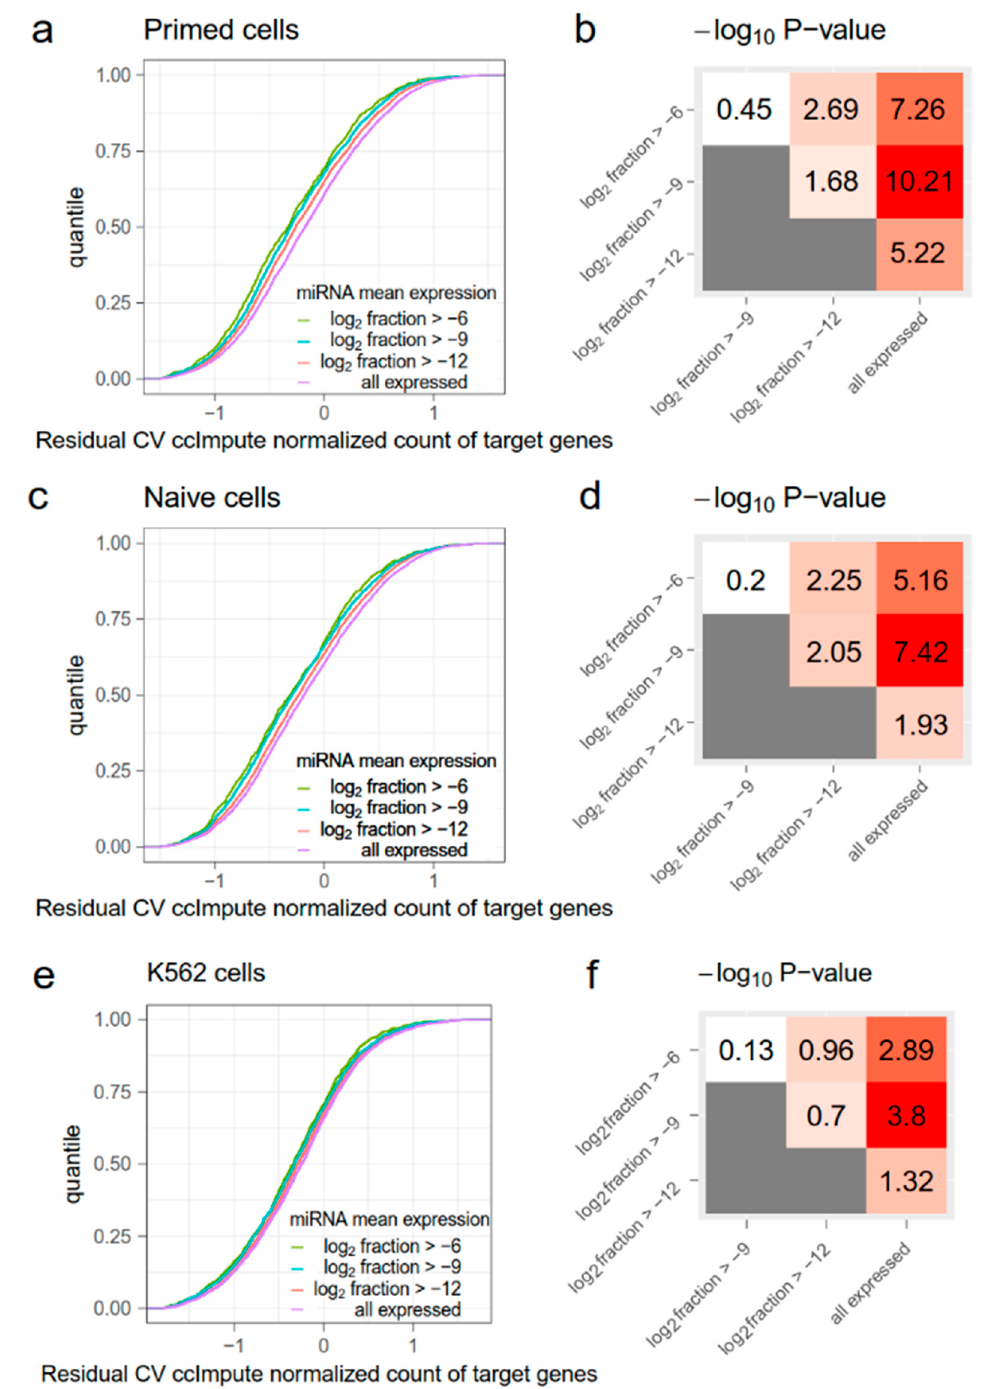
Figure A2. The evaluation of the noise-reduction effect of miRNAs using ccImpute. The organization of this figure is the same as for Figure 1. ( a , c , e ) Cumulative distribution functions (CDFs) of residual coefficient of variation (RCV) normalized counts of target genes in primed cells ( a ), naïve cells ( c ), and K562 cells ( e ). Target genes are grouped by miRNA mean expression levels. As the miRNA mean expression level increases, the RCV ccImpute normalized count of their target genes significantly decreases. ( b , d , f ) Kolmogorov–Smirnov (KS)-test − log10 ( p ) values between CDFs in ( a , c , e ). Red indicates higher statistical significance and white indicates lower statistical significance.